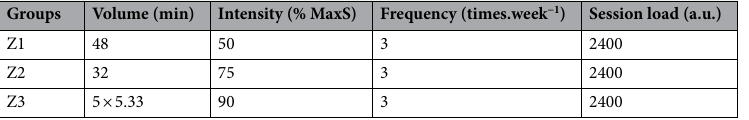
Table 1. Variables that compose the prescribed training sessions. Z1 = low intensity training group; Z2 = moderate intensity training group; Z3 = high intensity training group; MaxS = maximal running speed; a. u. = arbitrary